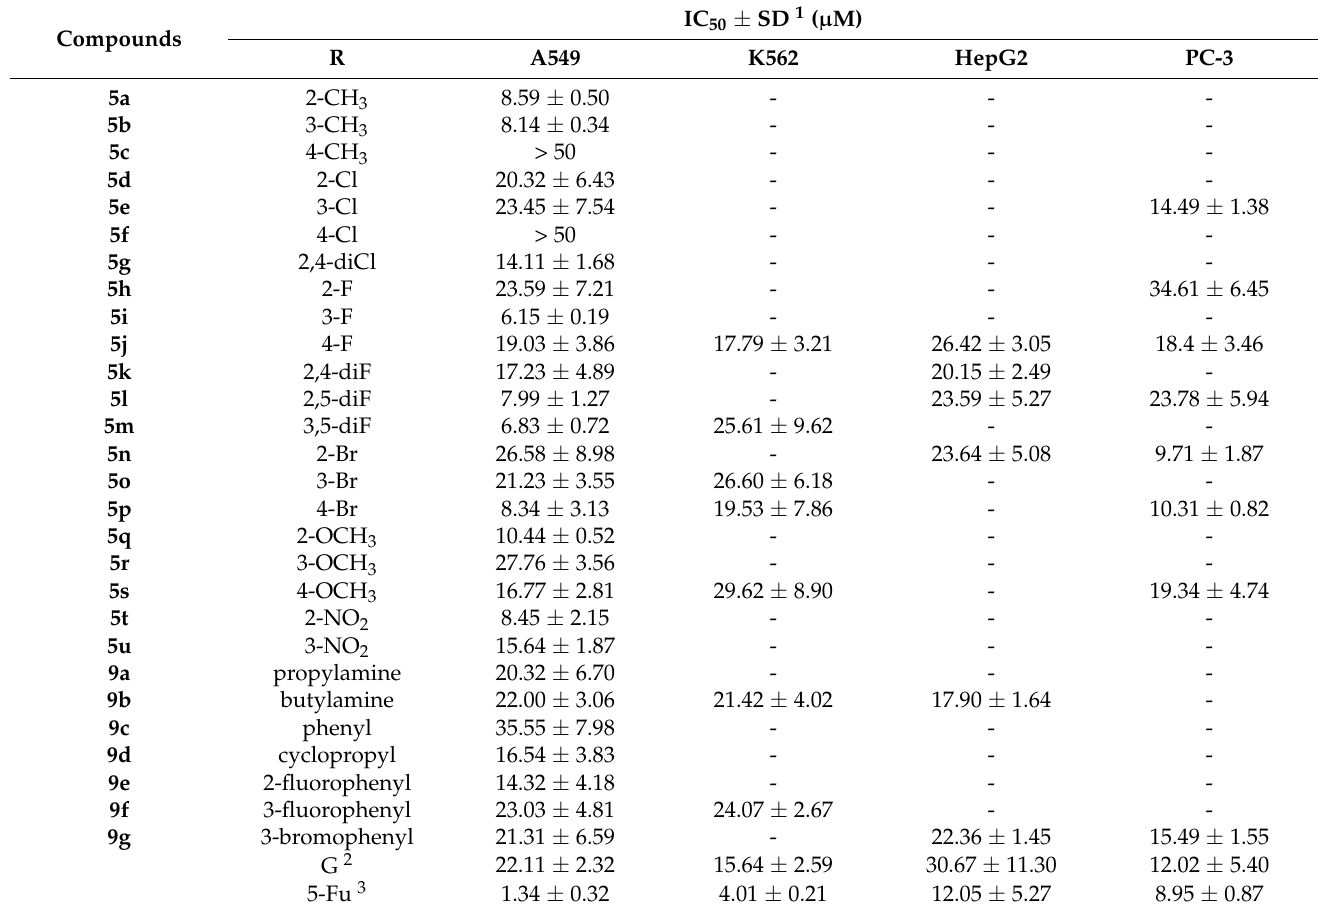
Table 1. The anti-proliferative activity of 1,4-naphthoquinone derivatives on cell carcinoma lines after 48 h